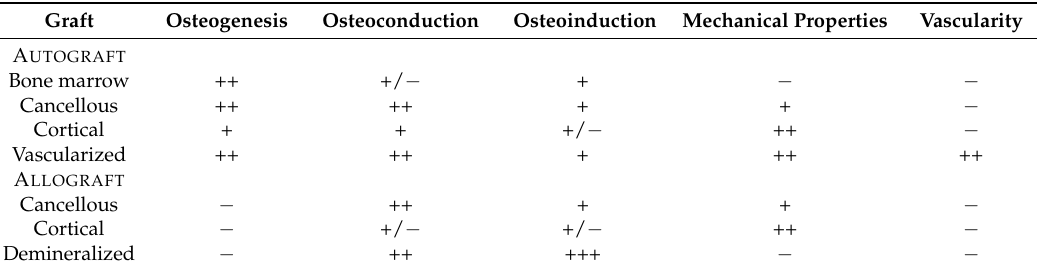
Table 1. Bone graft activity by